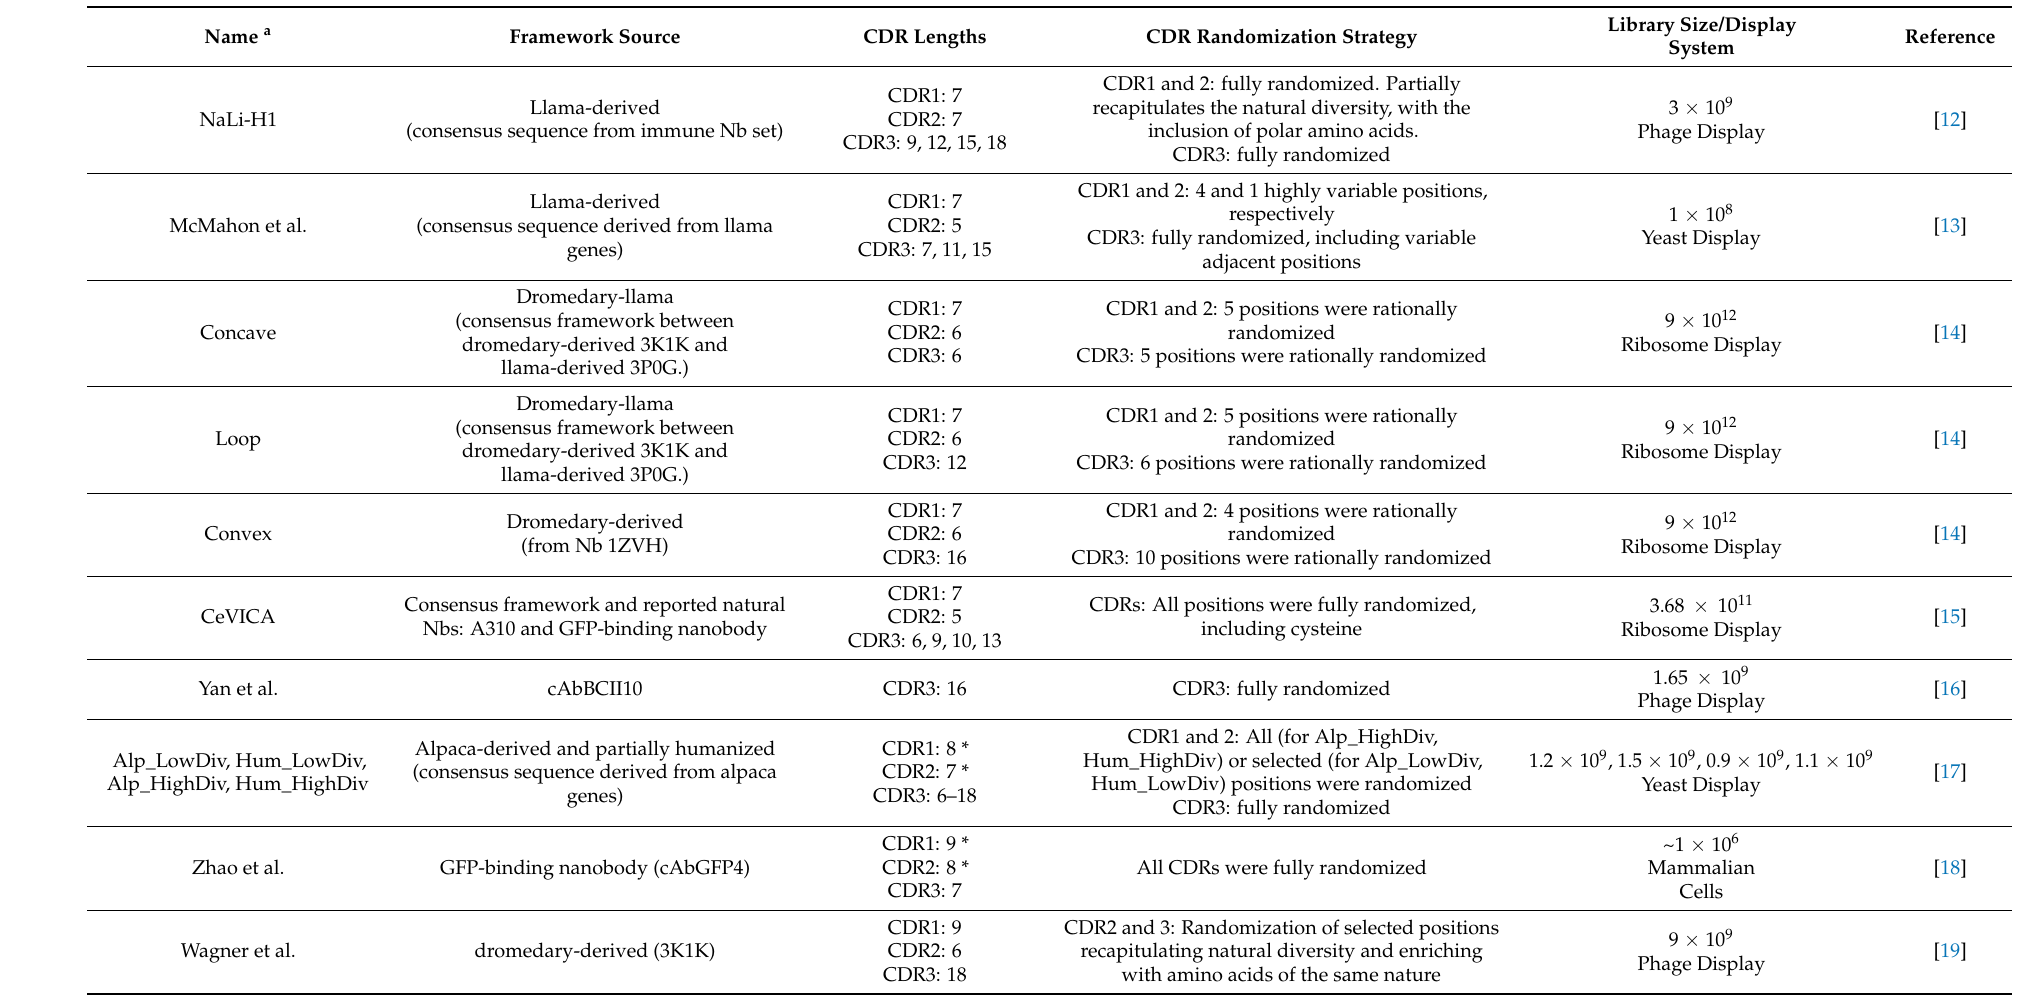
Table 1. Synthetic and Semi-synthetic